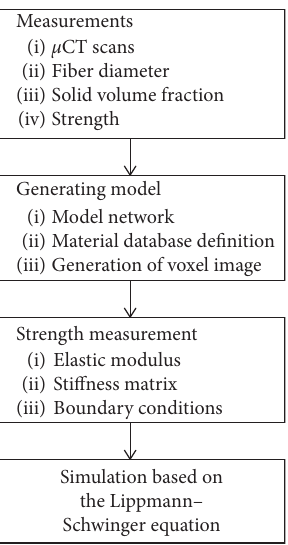
Figure 4: Overall scheme of the simulation used